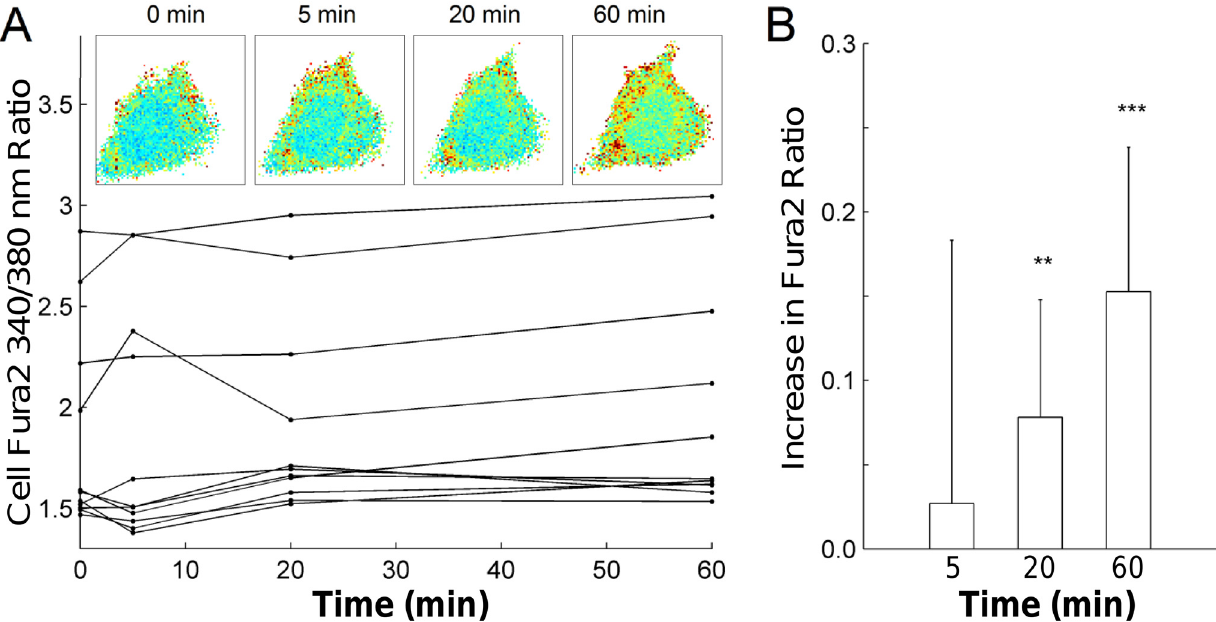
Fig 7. Response of intracellular calcium levels in bovine fibroblasts up to one hour of continuous sinusoidal stretching with maximum amplitude of 10% change in membrane surface area. Average ratios of Fura2 fluorescence at 340 and 380 nm excitation wavelengths were computed in each of 11 cells. Individual cell responses varied (A), but there was an overall trend of increasing Fura2 ratios over time, with significant increases present at 20 and 60 min relative to baseline (B). ** , p < 0.01; *** , p < 0.001